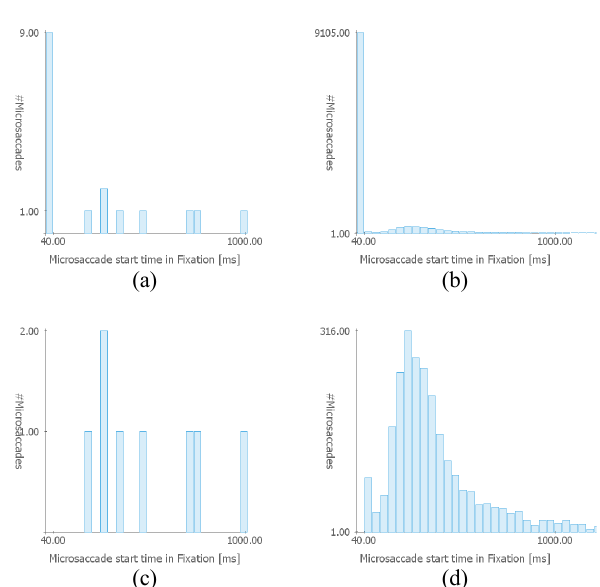
Figure 6. Temporal positions of detected microsaccades as a histogram for (a) one trial and (b) all trials of all participants in the painting data set (bin size: 40 ms). A high peak in the first bin indicates that many glissades (overshoots right after saccades, here in the subsequent 40 ms) were detected as microsaccades. Figures (c) and (d) show the same data when all microsaccades within the first 40 ms of a fixation are ignored from the